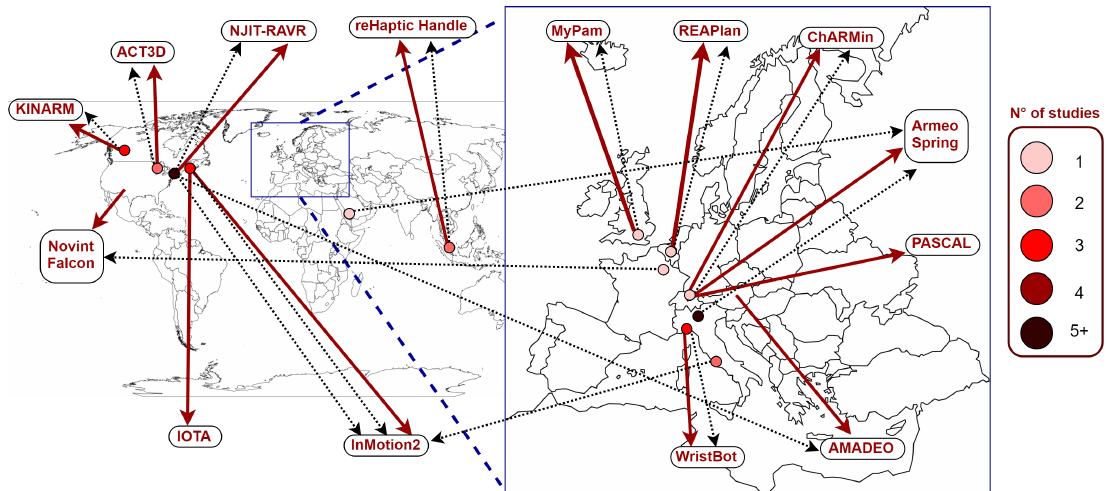
Figure 2. A world map identifying where robots for upper limb rehabilitation have been developed (red arrows) and where they have been used for children with neurological disorders (black dotted arrows). The color filling the circular areas indicates the number of clinical studies performed in the specific locations. The robot selected are: KINARM [46]; ACT3D [47]; NJIT-RAVR [48]; reHaptic Handle [49]; MyPam [50]; REAPlan [15]; ChARMin [51]; Armeo Spring [44]; PASCAL [52]; AMADEO [53]; WristBot [54]; InMotion2 [45]; IOTA [55]; Novint Falcon